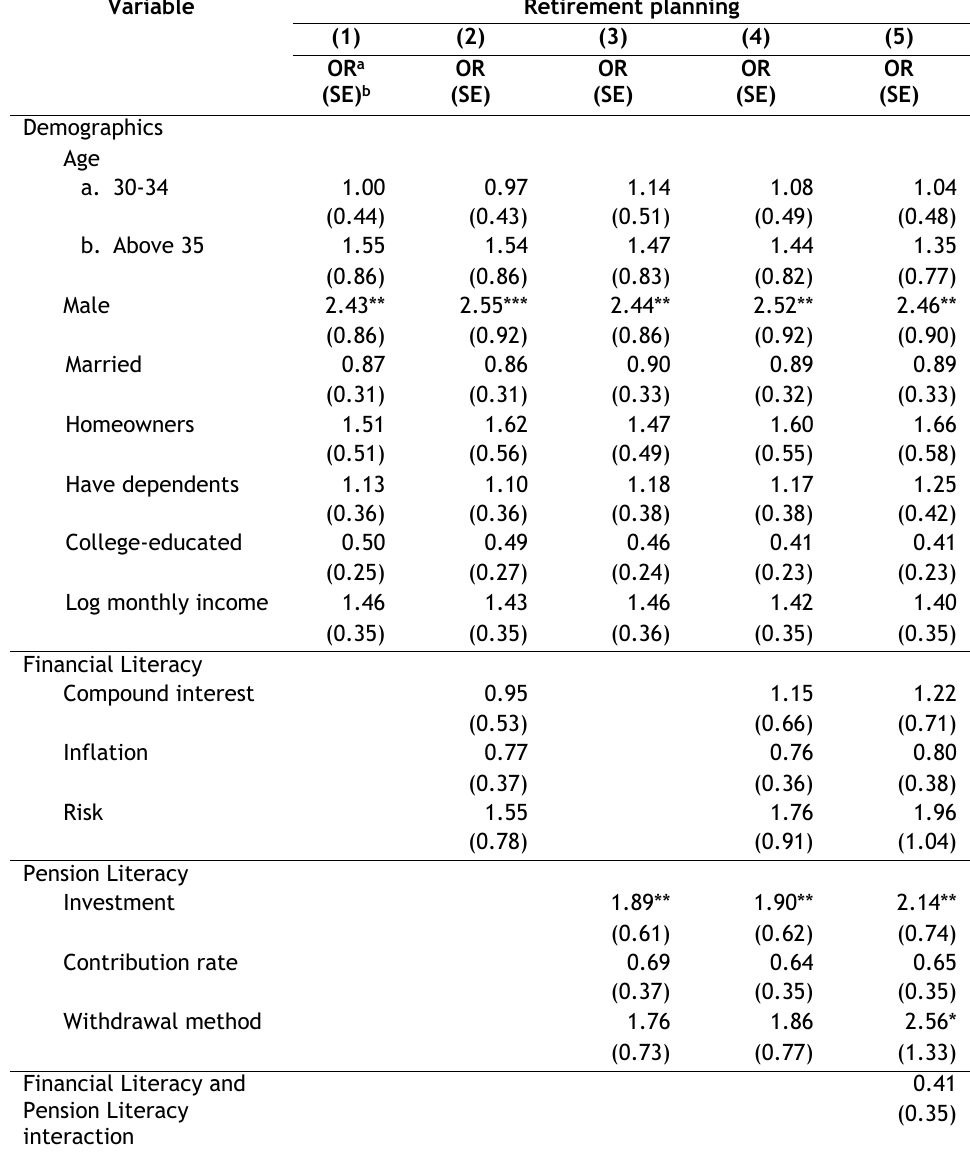
Table 3. Ordered logistic regression results for retirement